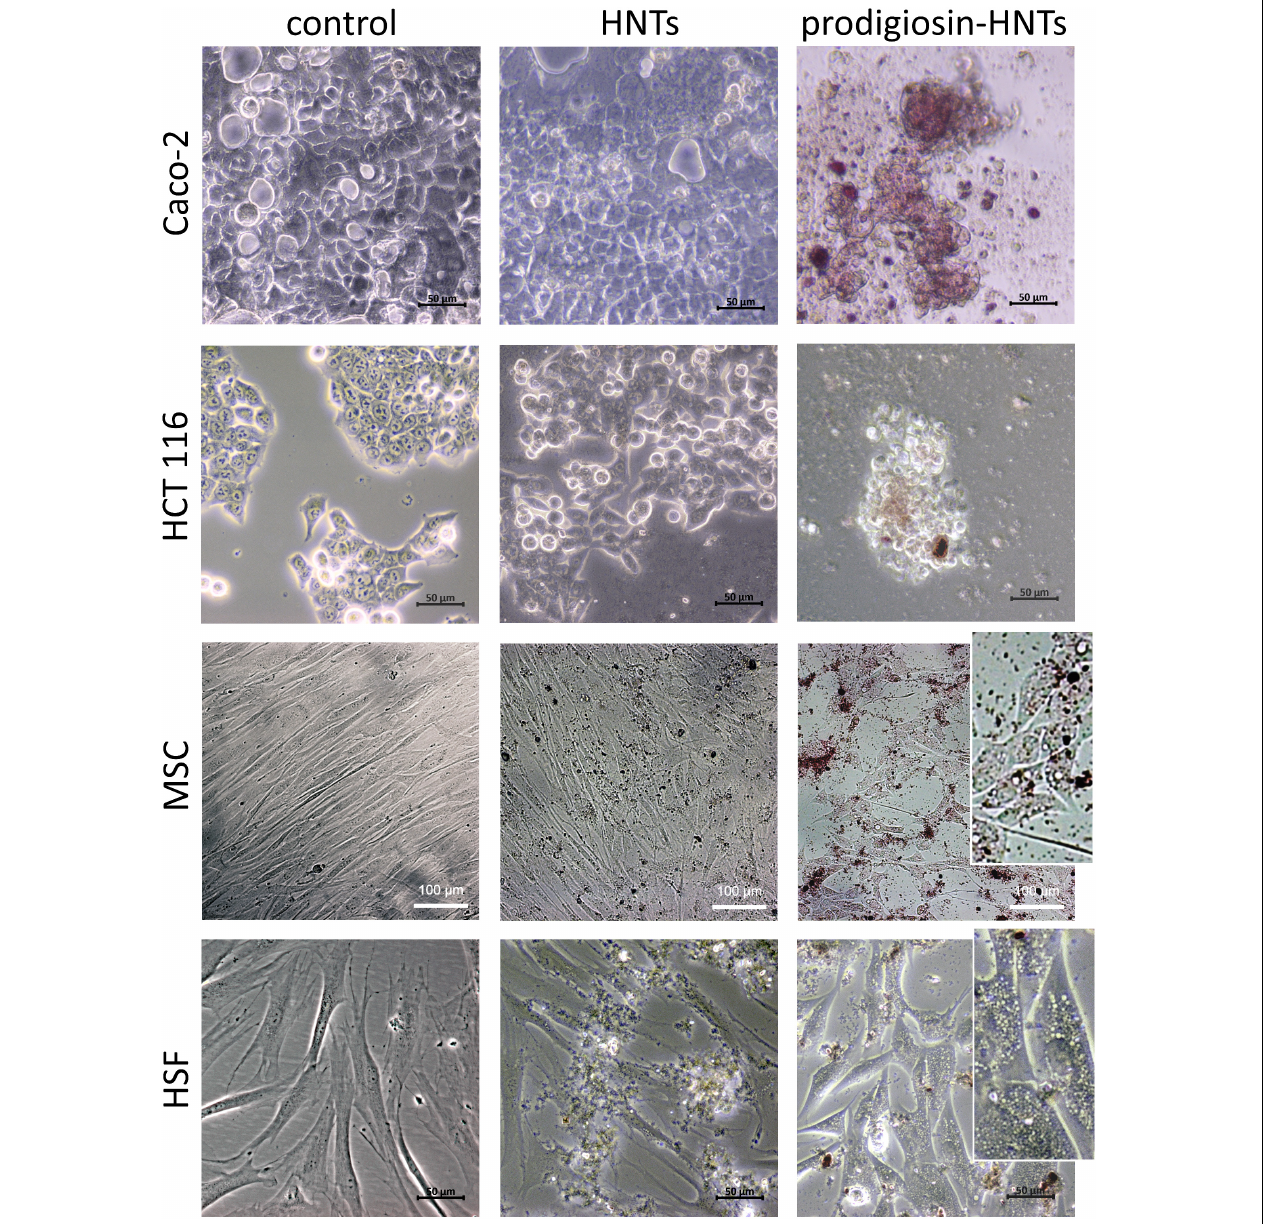
FIGURE 3 | Comparison of the effect of halloysite nanotubes loaded with glycerol (HNTs) and prodigiosin-HNTs on malignant (Caco-2, HCT116) and non-malignant cells (MSC, HSF). All cultures were grown in Minimum Essential Medium Eagle – Alpha Modification ( α -MEM) with 5% CO 2 in air and humidity at 37 ◦ C. The addition of prodigiosin-HNTs during the cultivation of cancer cells (Caco-2, HCT116) led to aberration of their morphology and subsequent detachment from the surface of the dish (Caco-2/prodigiosin-HNTs, HCT116/prodigiosin-HNTs). Glycerol-loaded HNTs which were used as a control did not affect the morphology and viability of all cell types. The presence of prodigiosin-HNTs in the culture medium of non-malignant cells increased the cytoplasm vacuolization of some cells (MSC/prodigiosin-HNTs and HSF/prodigiosin-HNTs